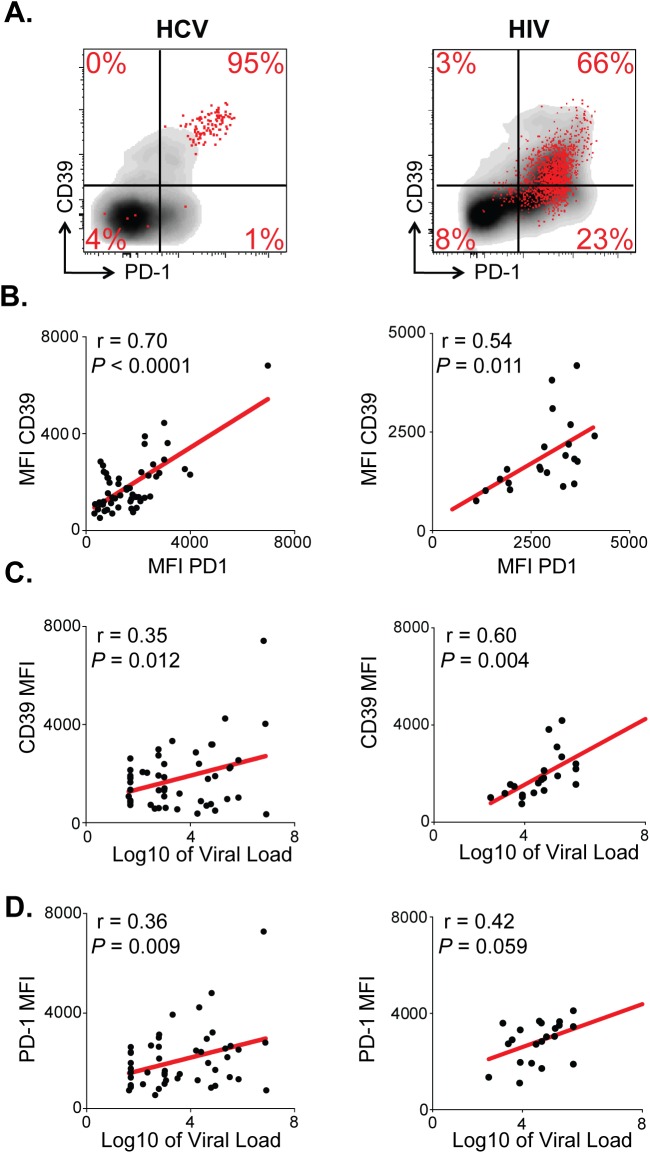
CD39 expression correlates with PD-1 expression and viral load in chronic viral infection.
(A) CD39 and PD-1 expression in chronic HCV (left) or HIV infection (right). Representative plots demonstrate total (gray) and virus-specific (red) CD8+ T cells. (B) Correlation between CD39 and PD-1 expression by HCV- (left) and HIV-specific (right) CD8+ T cells. (C) Correlation between CD39 expression by virus-specific CD8+ T cells and viral load count in HCV (left) or HIV (right) infection. (D) Correlation between PD-1 expression by virus-specific CD8+ T cells and viral load in HCV (left) or HIV (right) infection. Correlation was assessed by Pearson correlation coefficient (B, C, D). MFI; mean fluorescence intensity.